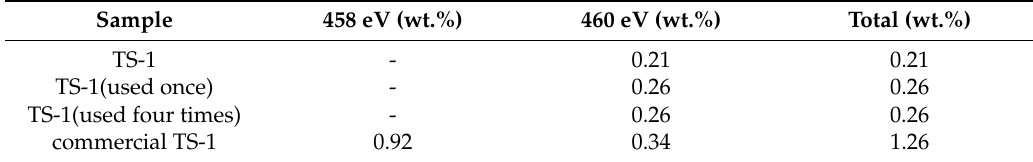
Table 1. Surface Ti content of catalysts.